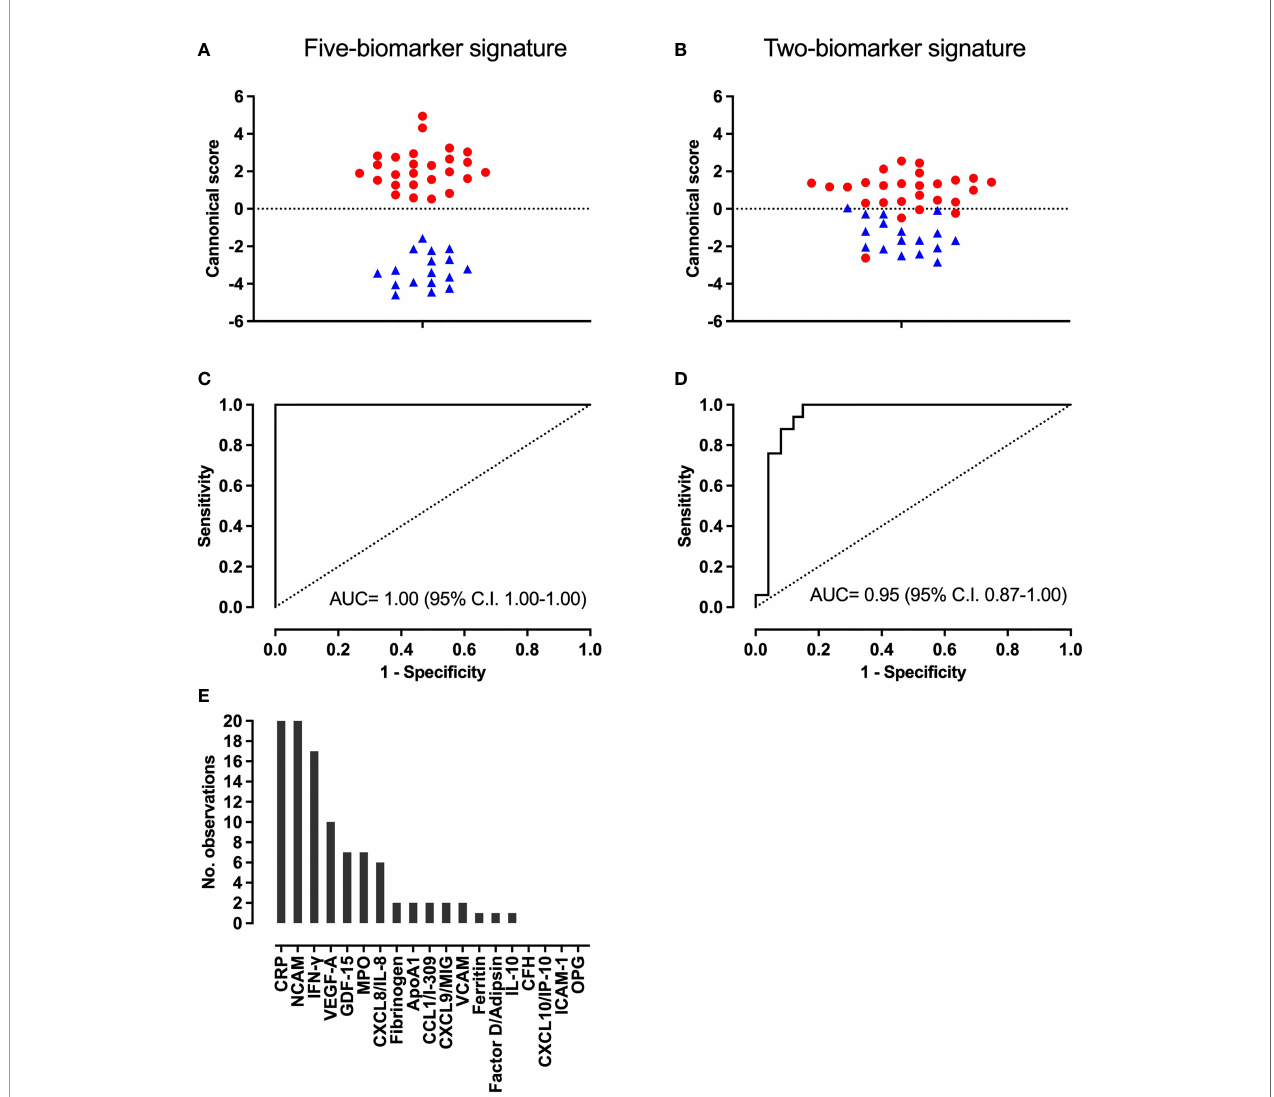
FIGURE 2 | Accuracy of the new fi ve-biomarker signature (CRP, NCAM, Ferritin, CXCL8 and GDF-15) and existing two-marker biosignature (CRP and CCL1) for distinguishing spinal TB and mechanical back pain. (A, B) Plot of canonical scores derived from each model, (C, D) , Receiver Operating Characteristic plots showing the accuracy of each model and (E) Number of times each biomarker appeared in the top 20 fi ve-biomarker General Discriminant Analysis models for discriminating between spinal TB and mechanical back pain. In panels (A, B) , red dots and blue triangles represent the scores of individuals with spinal TB and mechanical back pain,